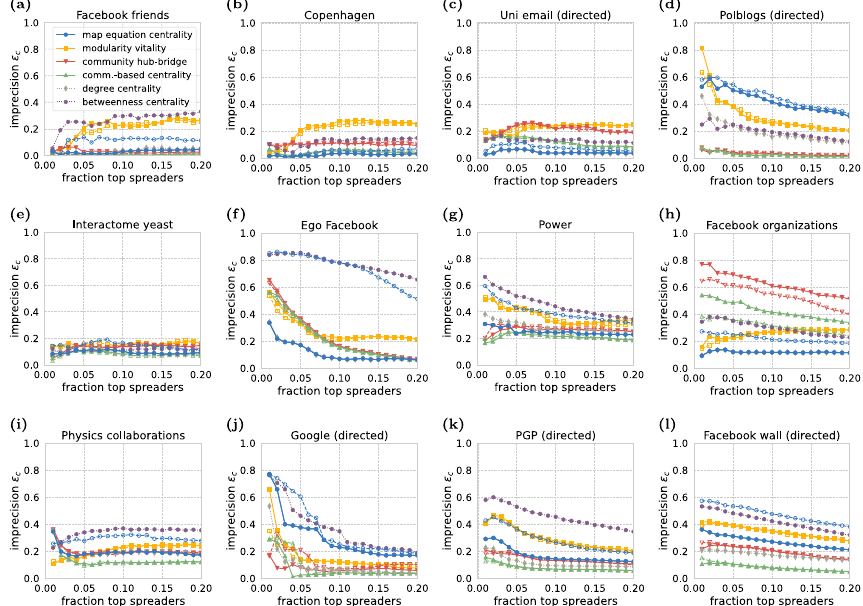
Fig. 6 Imprecision of map equation centrality, modularity vitality, community hub-bridge, community-based centrality, degree centrality, and betweenness centrality for identifying top spreaders in eight empirical networks. The curves show imprecision as a function of the fraction of top spreaders that are selected. A lower imprecision corresponds to more accurately identifying the top spreaders as determined with an SIR simulation. Community structures are identified with Infomap; solid lines use the unrecorded link teleportation flow model, dashed lines use recorded node teleportation. Degree and betweenness centrality do not rely on